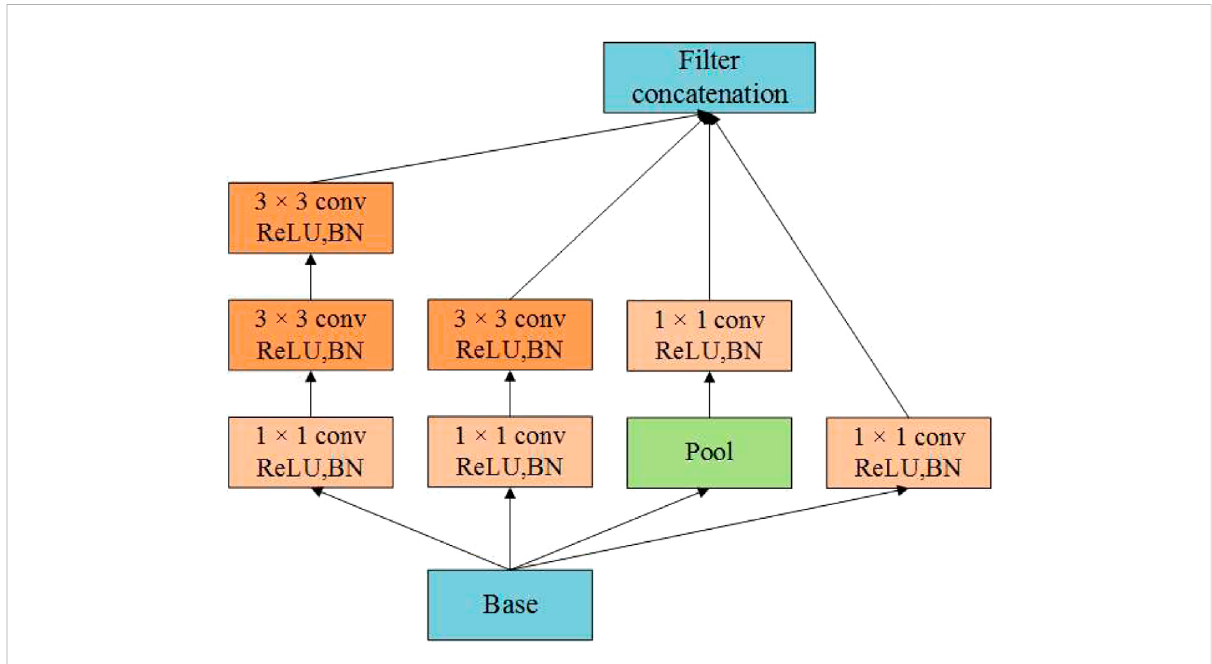
FIGURE 6 The topology of Inception-V3.